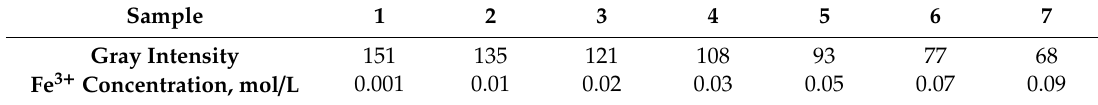
Table 1. Iron ion concentration of samples 1–7 and their corresponding gray